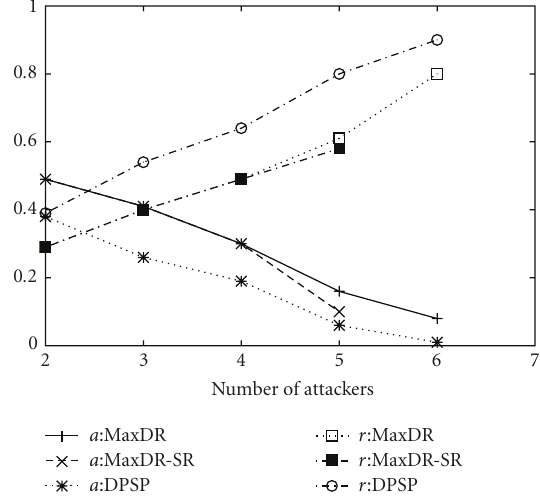
Figure 3: Multiple-attacker case: scenario 1. Figure 4: Multiple-attacker case: scenario